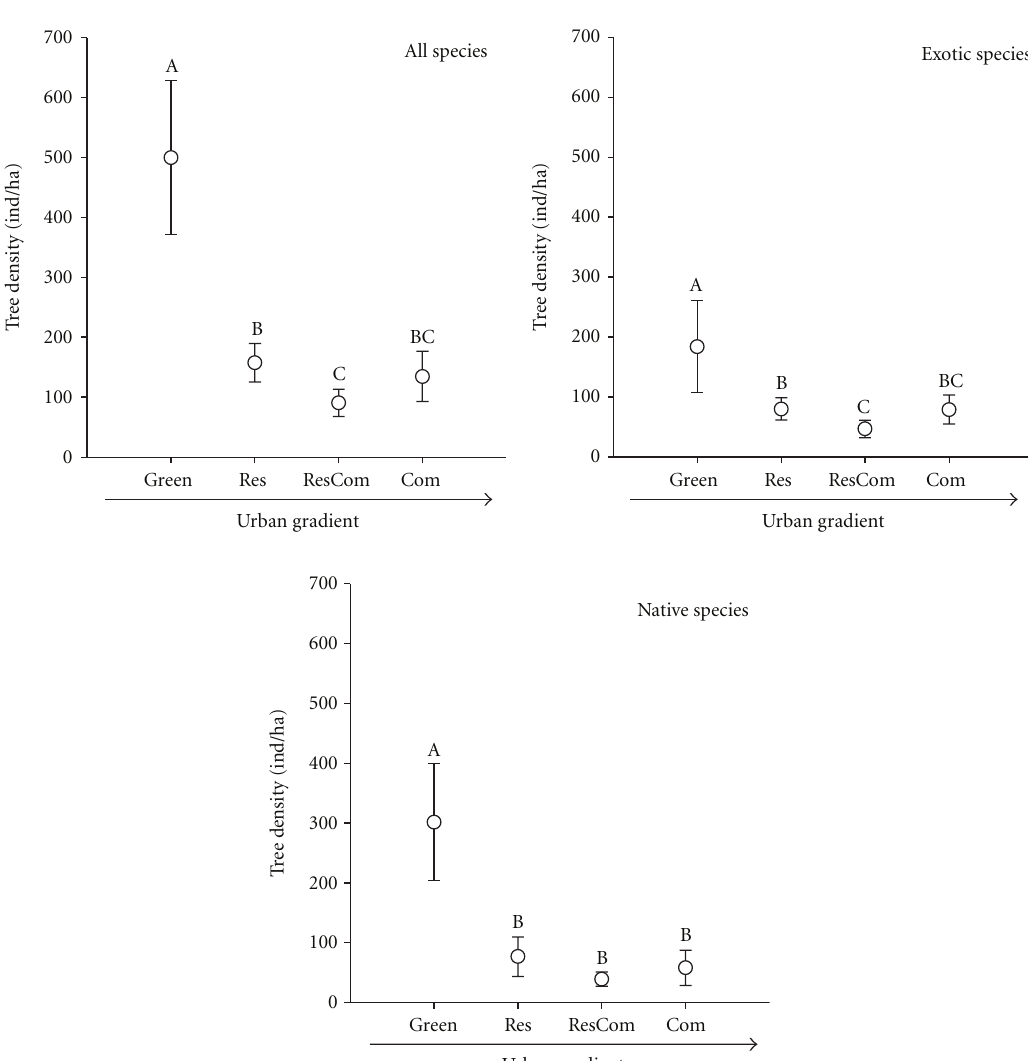
Figure 3: Total, exotic, and native tree species density (ind/ha) average values ( ± 95% confidence intervals) for the studied urban land uses. Letters represent statistical di ff erences. Green: green areas, Res: residential areas, ResCom: residential-commercial areas, Com: commercial